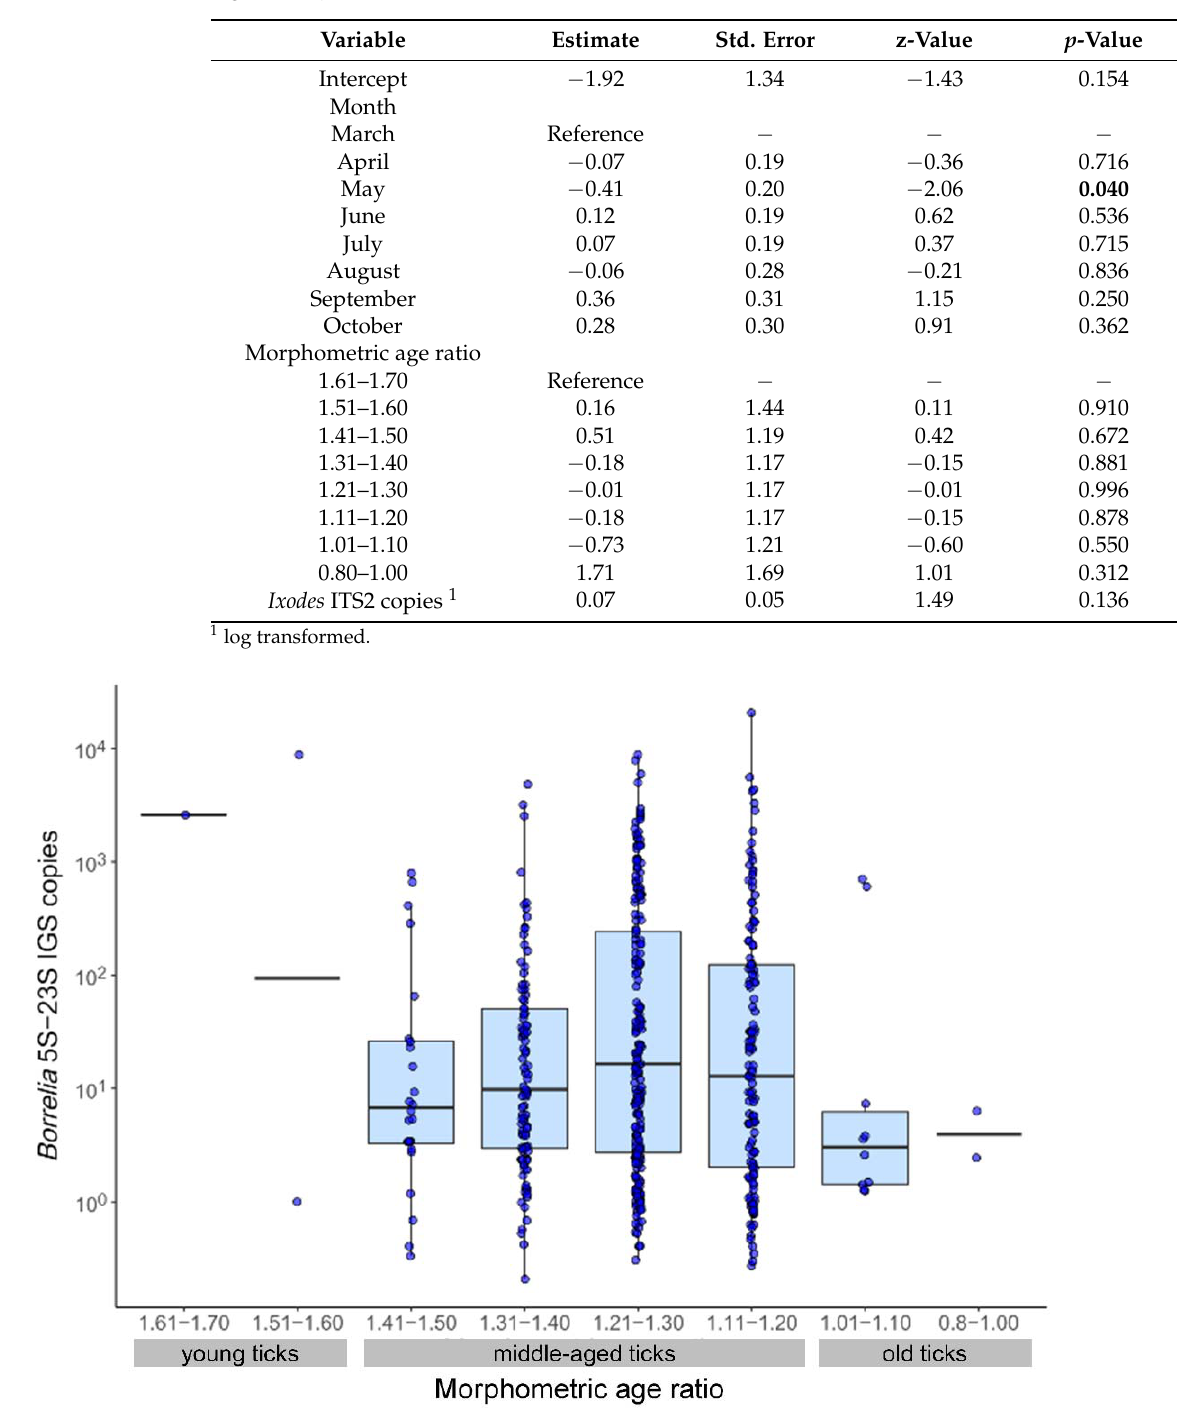
Figure 3. Borrelia 5S–23S IGS copies in the different morphometric age groups. Boxplots are shown for groups with n ≥ 5, while individual data points are shown in dark blue. The thick line indicates the